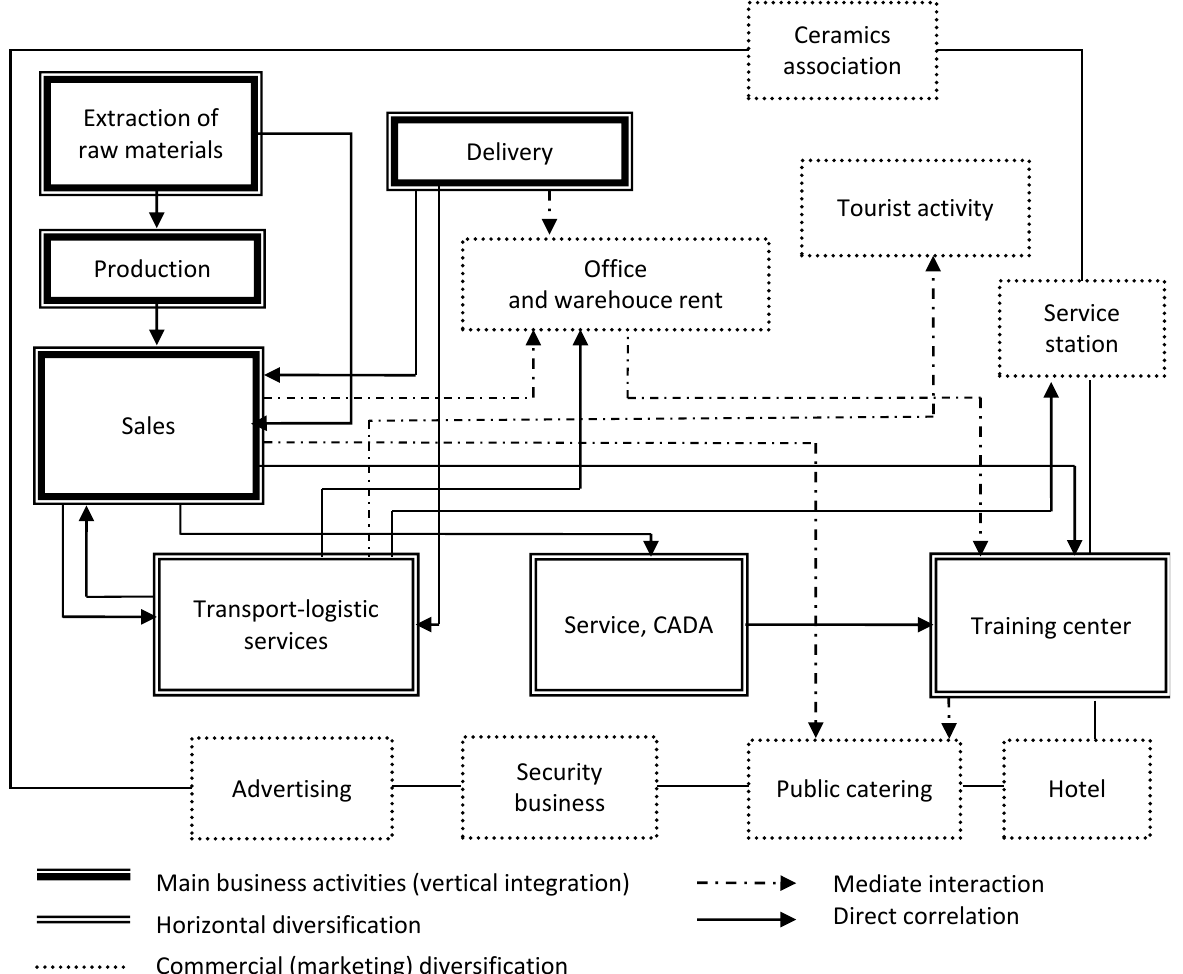
Figure 2. Ahromat Group business